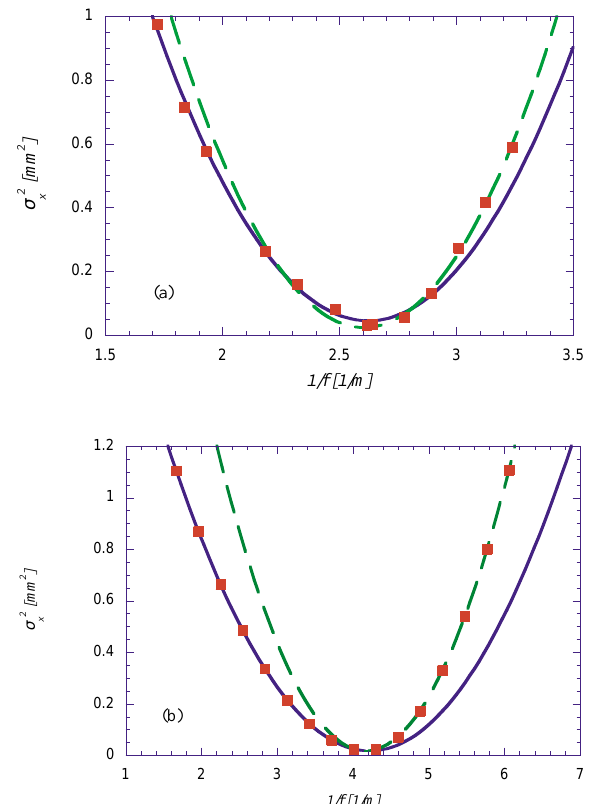
FIG. 10. (Color) (a) Quad scan data as shown in Fig. 4(b). Here we apply different fits to the data before and after the focus. (b) Simulation of a quad scan with an extremely space-charge dominated beam. Again, we show the two fits on either side of the beam waist to illustrate the asymmetry in the simulation points.